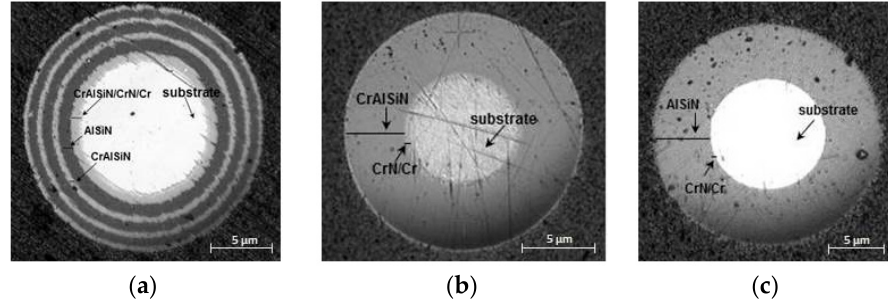
Figure 2. An image of the calotest crater of: ( a ) a compositionally modulated CrAlSiN–AlSiN coating; ( b ) a CrAlSiN nanocomposite; and ( c ) an AlSiN nanocomposite .